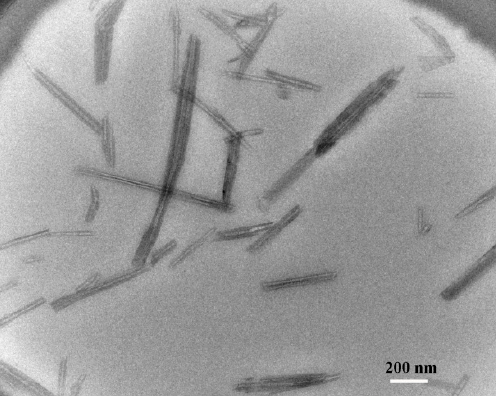
Figure 3. TEM micrographs of FG/GE40/HTs4.